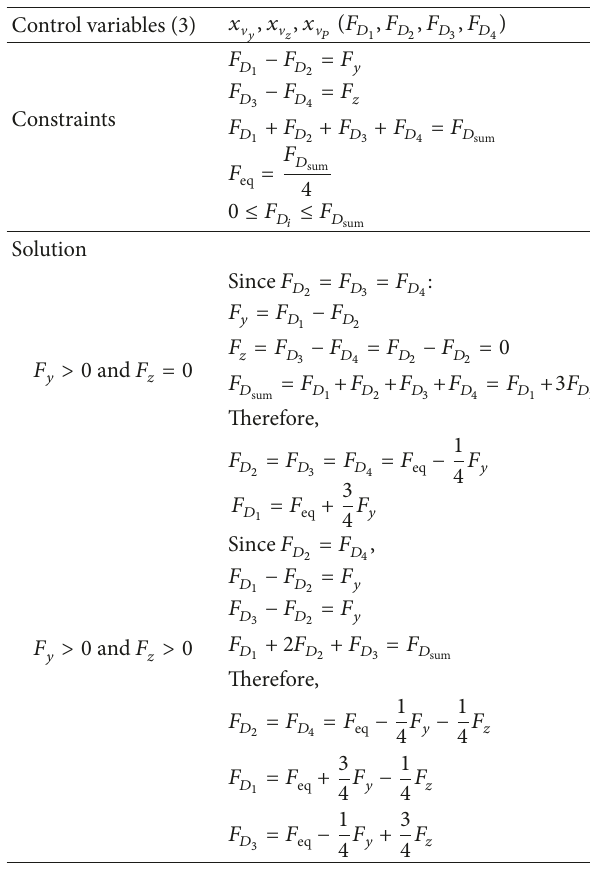
Table 3: Thrust distribution algorithm for the reduced